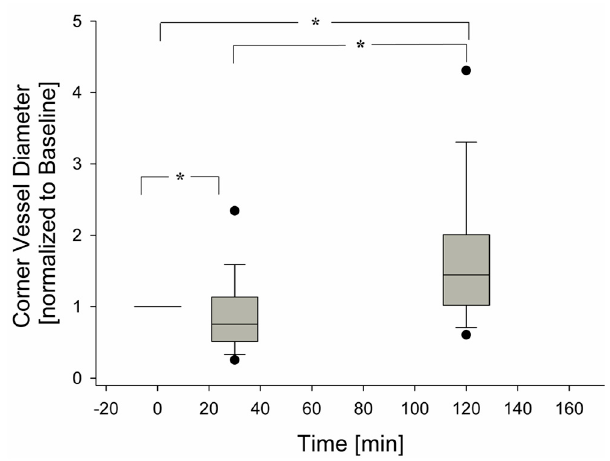
Figure 6. Change of corner vessel diameters over time, during hypoxia exposure (120 observations), (* = p < 0.05).